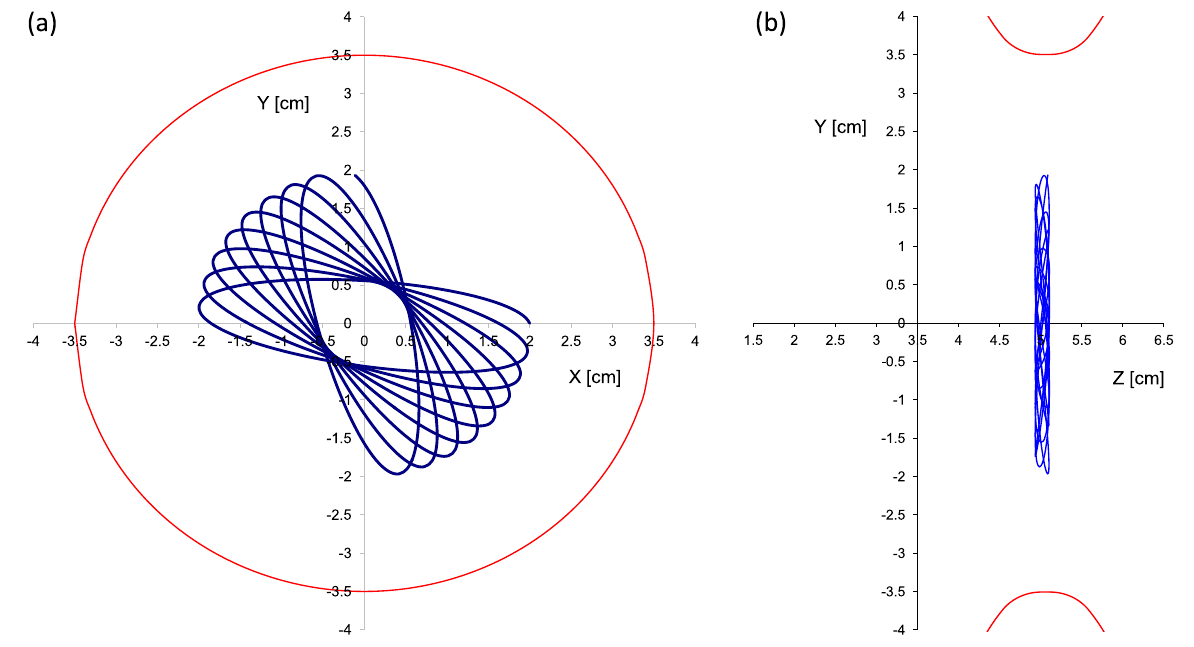
FIG. 3. Charged particle trajectory. (a) Projection on x-y plane and (b) projection z-y plane. Red line shows the aperture and shape of an iris.